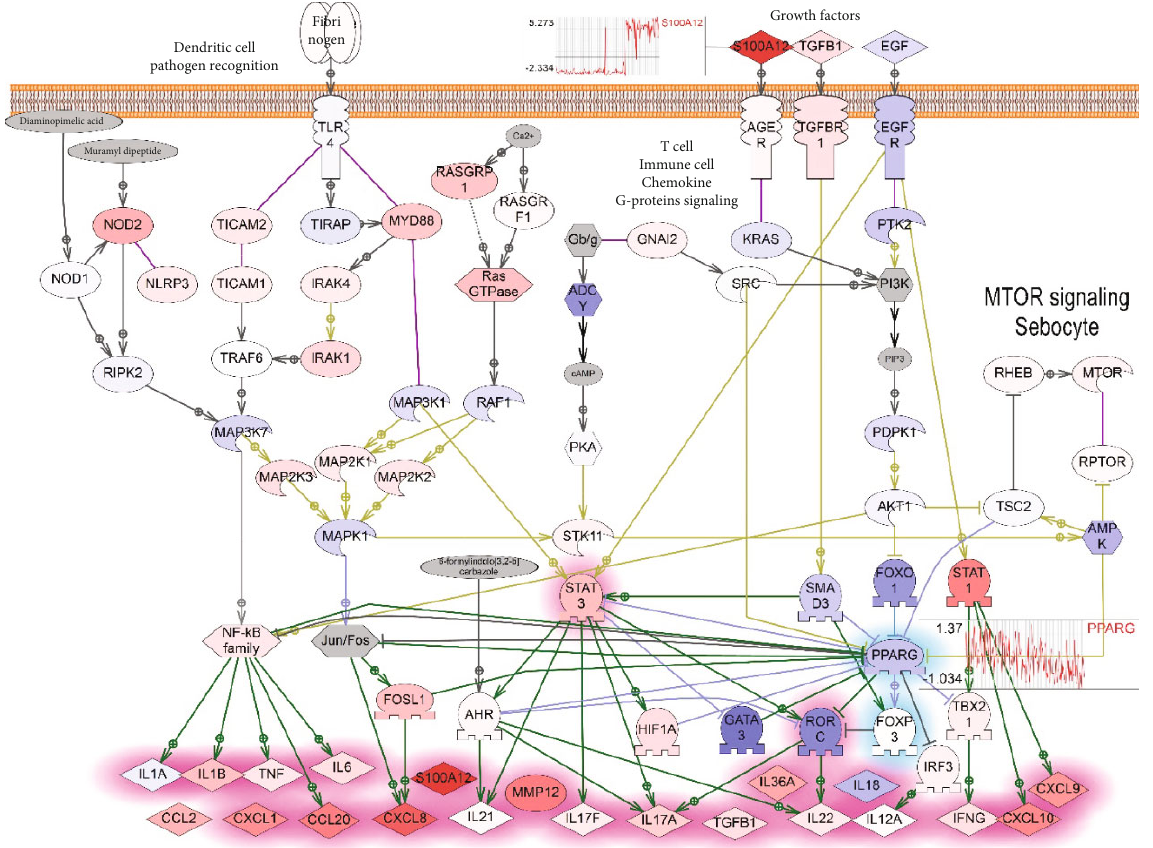
Figure 7: Evaluation of PPAR γ -downregulated model associated with psoriasis using microarray data analysis (results of di ff erential expression analysis of psoriatic lesions vs. unaltered lesions from GEO:GSE13355). The saturation in blue indicates the degree of gene downexpression in psoriatic samples in comparison with unaltered samples. The saturation in red indicates the degree of gene overexpression. The plots of expression pattern in psoriatic lesions compared with healthy skins samples are shown for PPAR γ and S100A12